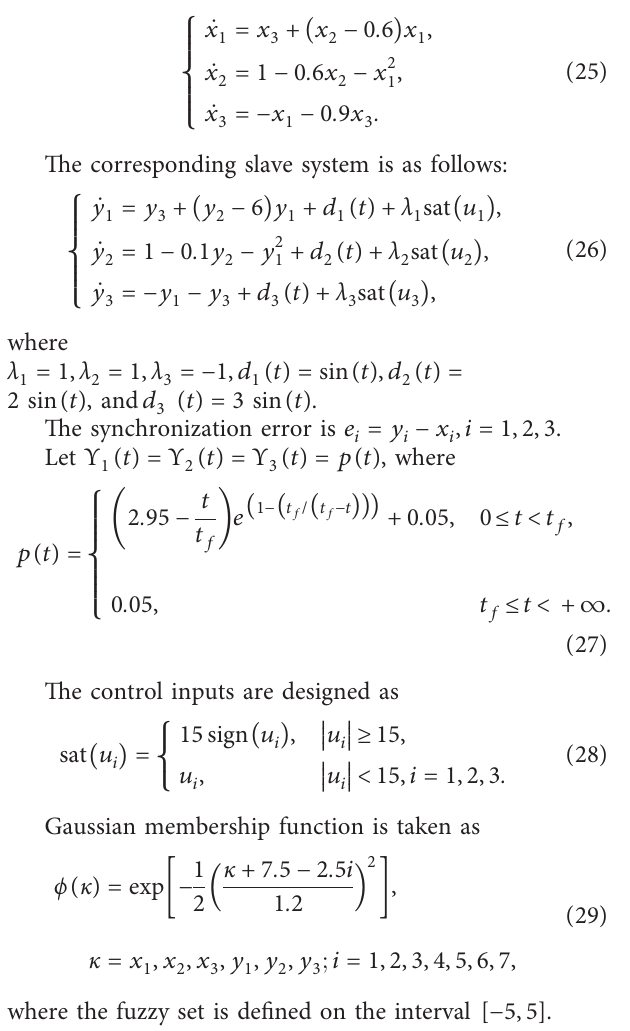
Figure 2: Trajectories of sat ( u